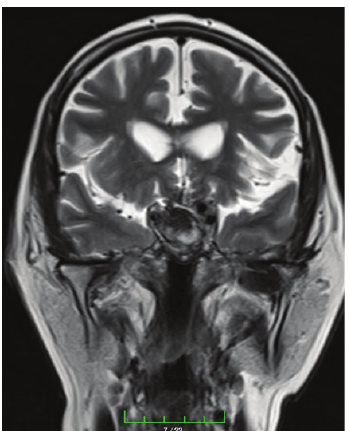
Figure 4: Coronal T2-weighted MR image after